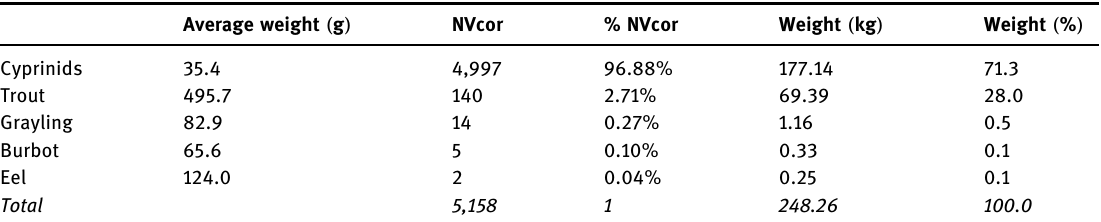
Table 6: Estimated relative amount of each fi sh species in kilograms based on corrected number of vertebrae ( NVcor ) ; average weight of specimens calculated on vertebral measurements ( samples in Figures 5 – 7